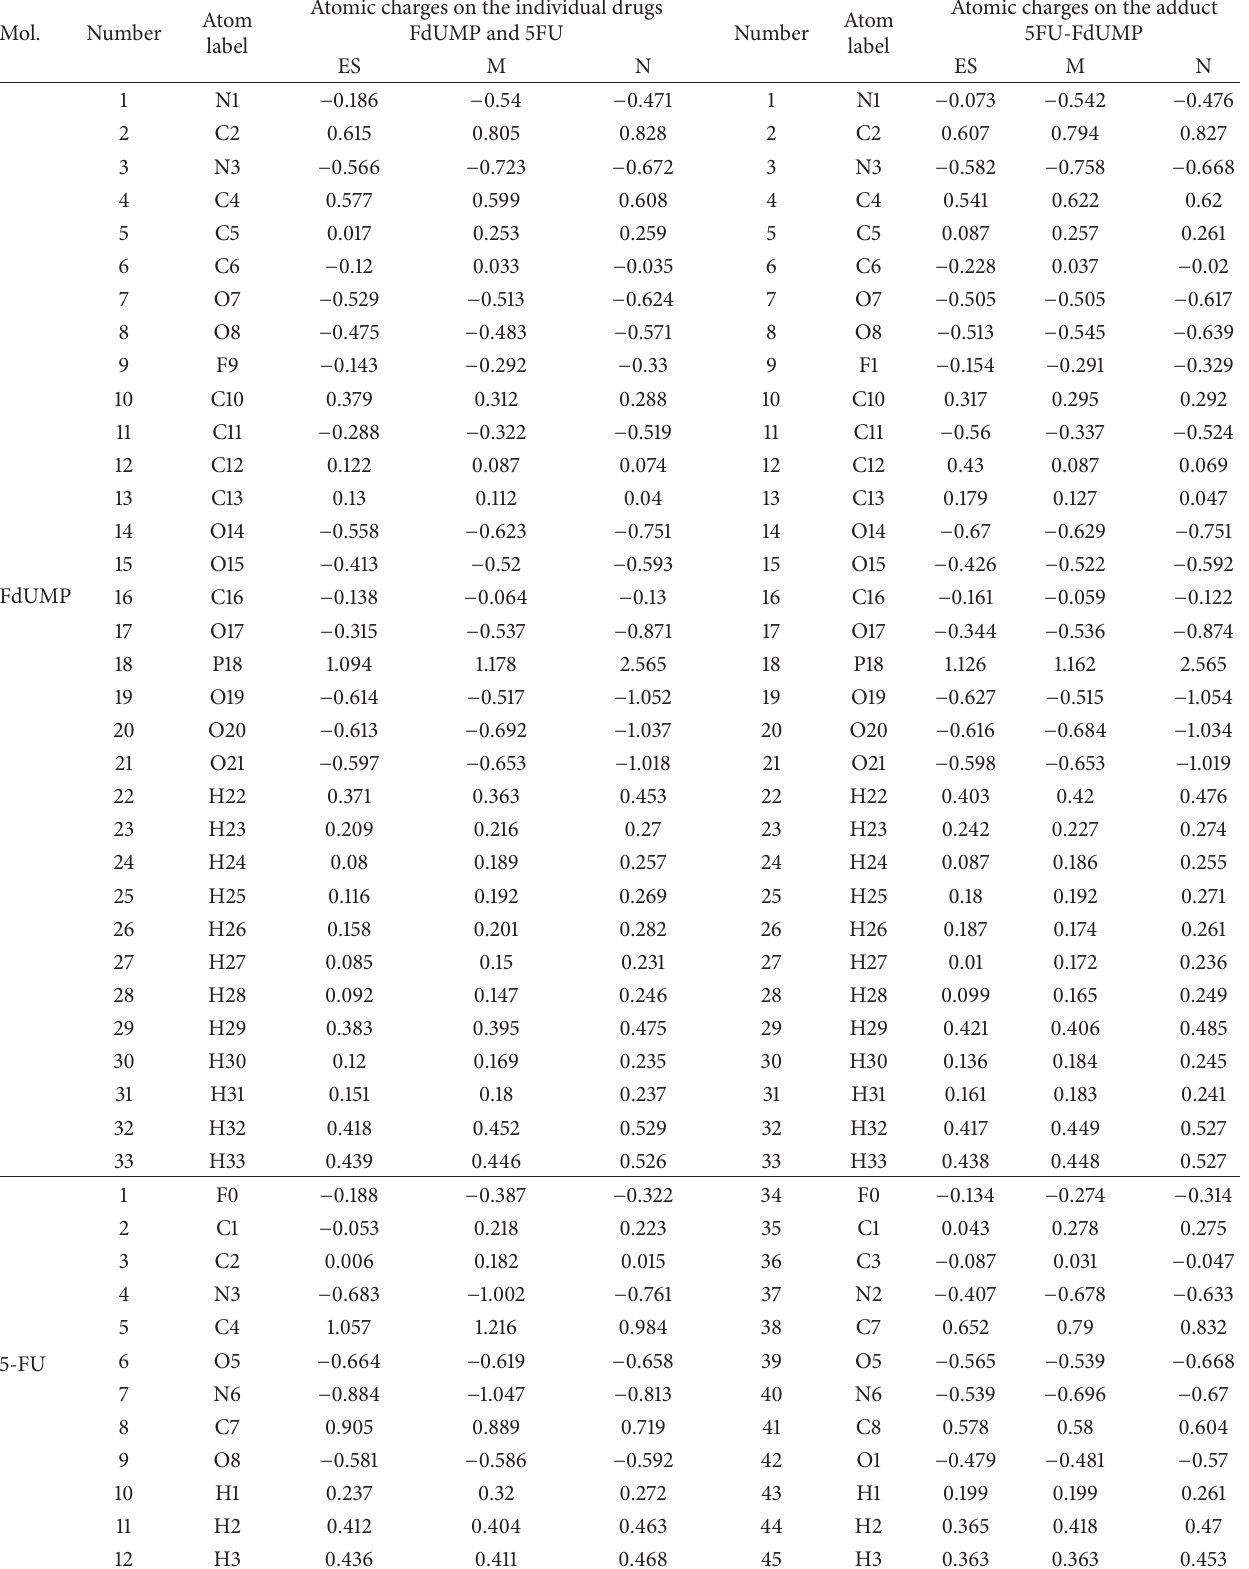
Table 3: Computed partial atomic charges on individual molecules and on the adduct resulting from the interactions between 5-FU and the in-body produced FdUMP enzyme suicide agent of TS enzyme (ES = electrostatic, M = Mulliken, and N = natural charge).